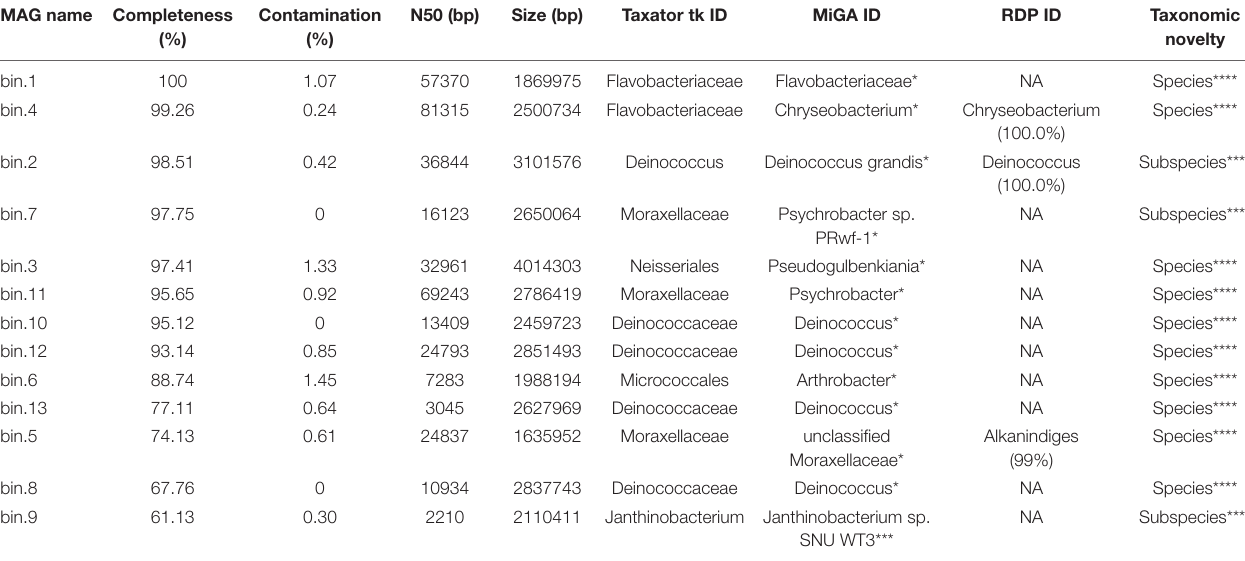
TABLE 1 | Statistics of the MAGs